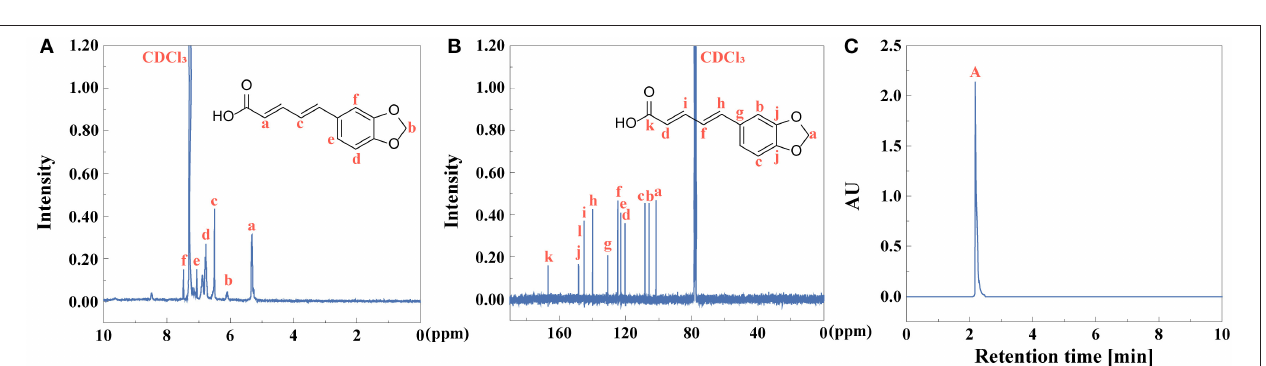
FIGURE 8 | (A) 1 H NMR, (B) 13 C NMR, and (C) HPLC (peak A : piperic acid) of piperic acid.